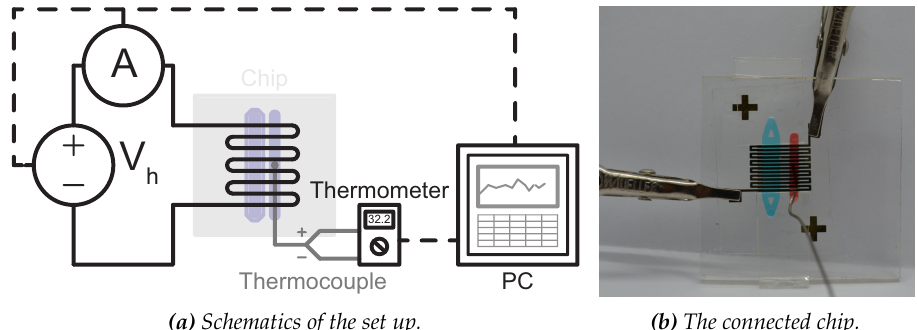
Figure 12. The set up for MDA reacions, ( a ) the schematics in which the voltage source is a Keithley SourceMeter, the thermocouple is connected to a Tenma thermometer. ( b ) The DNA amplification chip (both the amplification chamber and temperature control chamber are filled with food coloring dye for visualization